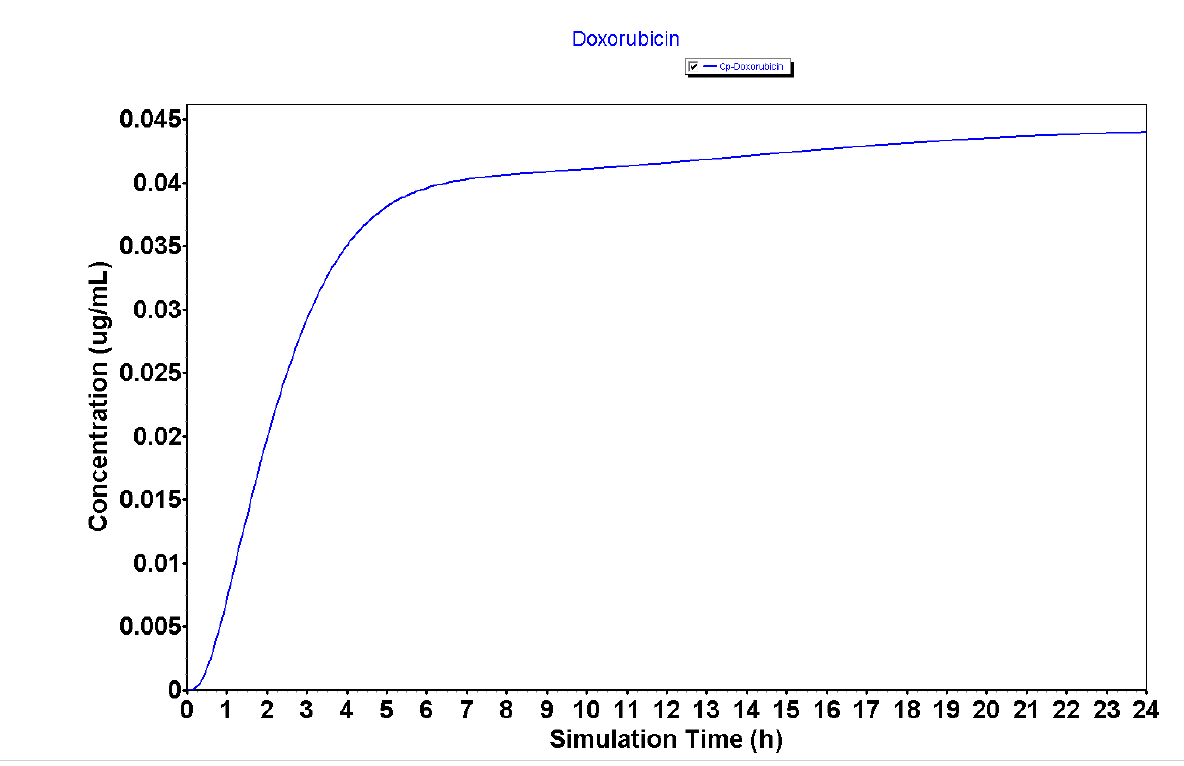
Figure 2. Plasma concentration of DOXO generated using the GastroPlus ® software.